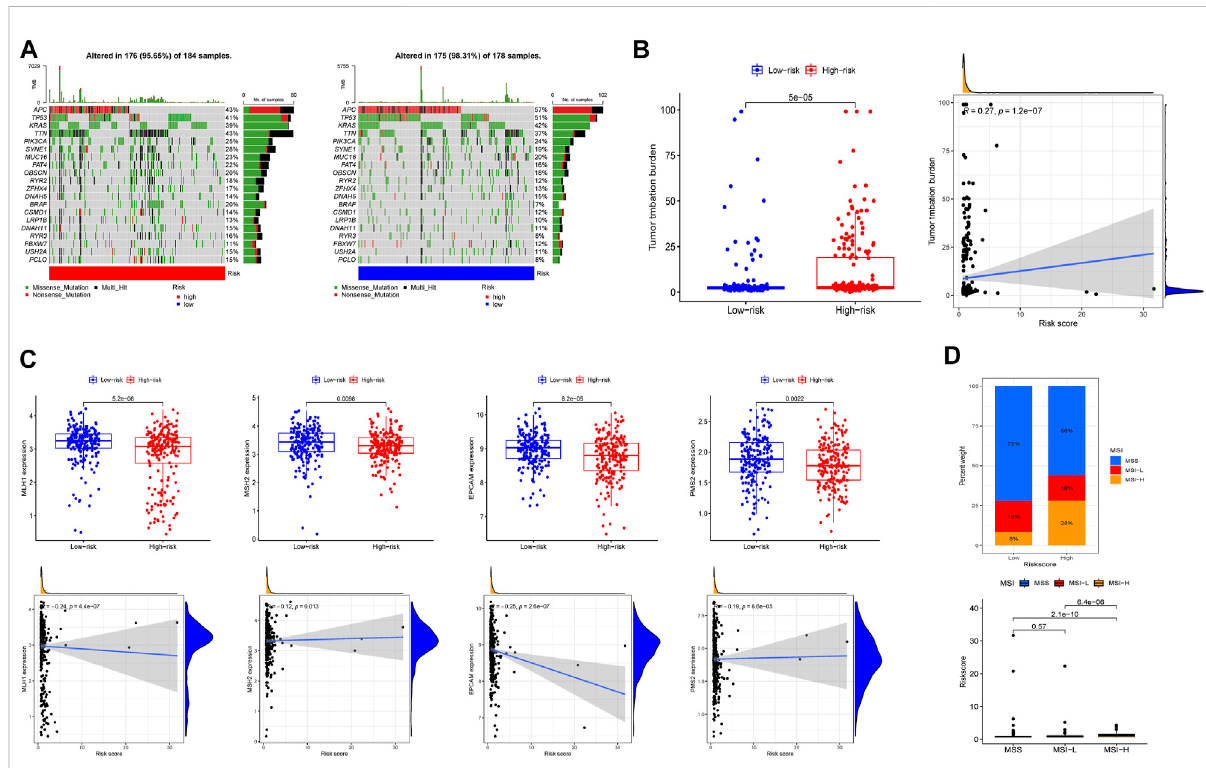
FIGURE 7 Tumor mutational burden, somatic mutation, and microsatellite instability (MSI) analysis in high-risk and low-risk groups. (A) The waterfall plot displayed the mutation of 20 genes. (B) The differences of TMB, the relationship between TMB and risk score. (C) The expression level of MLH1, MSH2, EPCAM, PMS2 and the relationship of expression and risk score. (D) The proportion of different microsatellite states and the risk score of different microsatellite